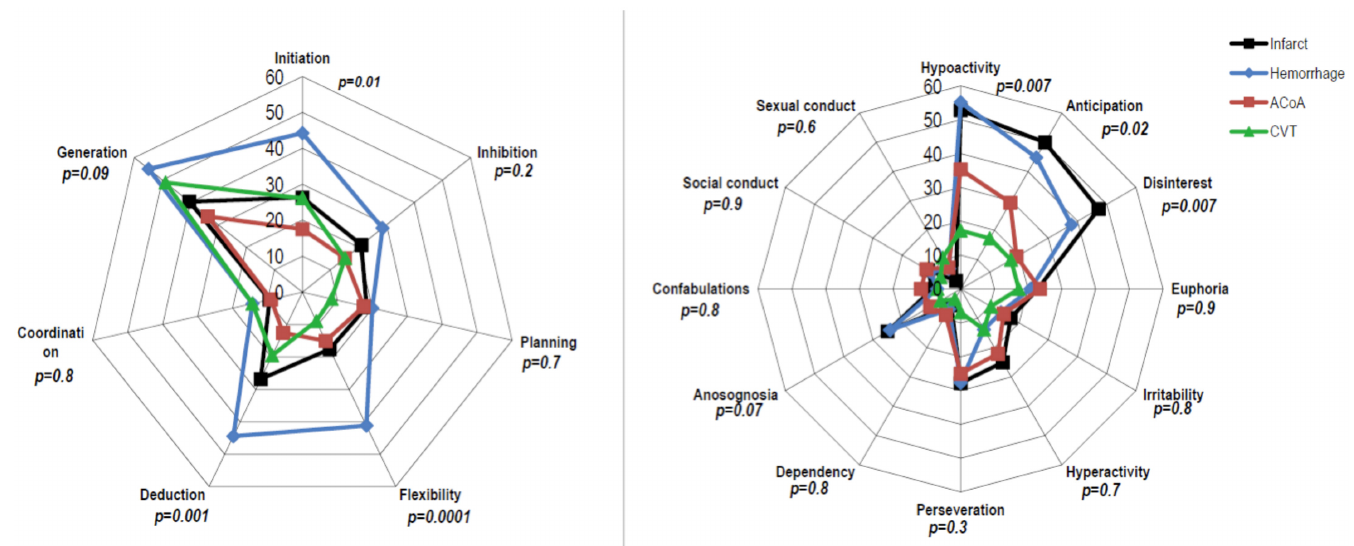
Fig 1. The profile (frequency %) of cognitive (left) and behavioral (right) disorders as a function of the stroke subtype.